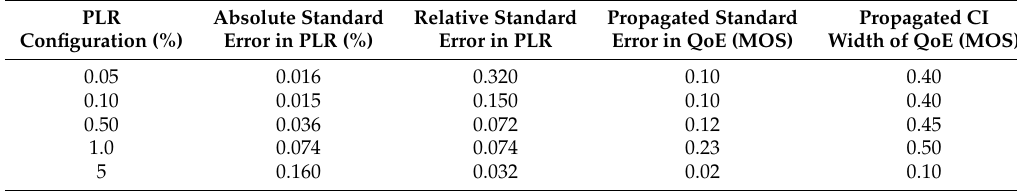
Table 4. NetEm PLR uncertainty and propagated error in